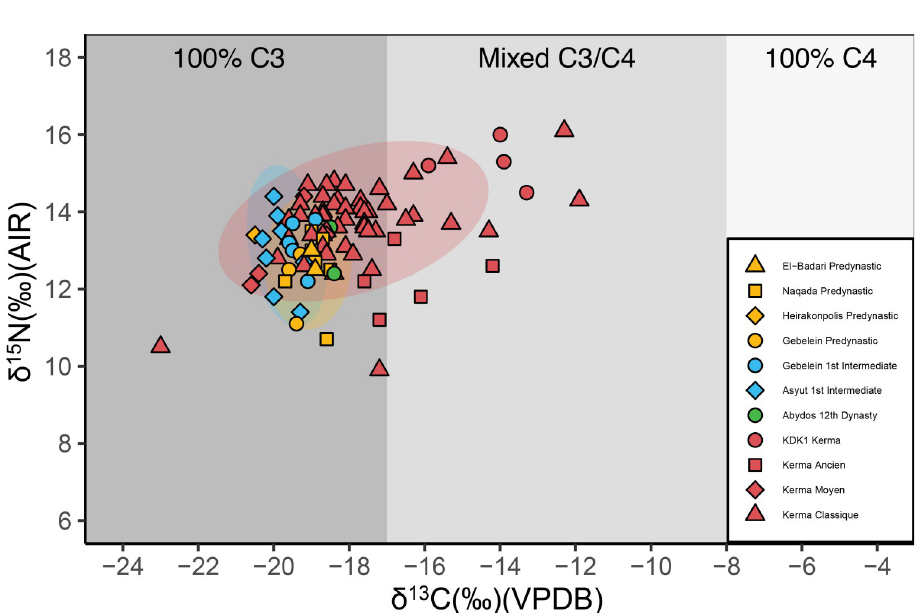
Fig 15. δ 13 C and δ 15 N collagen measurements of humans from this study and relevant Egyptian and Upper Nubian Nile Valley sites prior to New Kingdom conquest 1500 BCE. Refer to S28 Table in S1 File for mean values. Abydos, El-Badari, Naqada and Hierakonpolis [55], Gebelein and Asyut [53], Kerma Ancien , Moyen and Classique refer to Eastern Cemetery individuals [52, 54]. Shading indicates estimated collagen δ 13 C for individuals consuming 100% C 3 , mixed C 3 /C 4 , and 100% C 4 sources [208]. VPDB = Vienna Pee Dee Belemnite. AIR = Ambient Inhalable Reservoir.